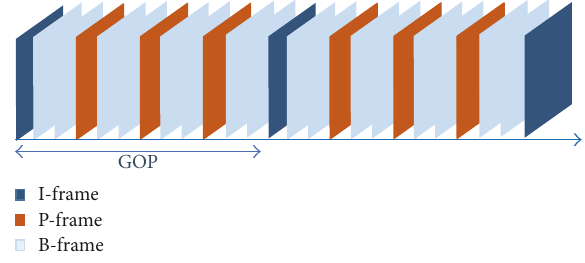
Figure 2: Typical frame